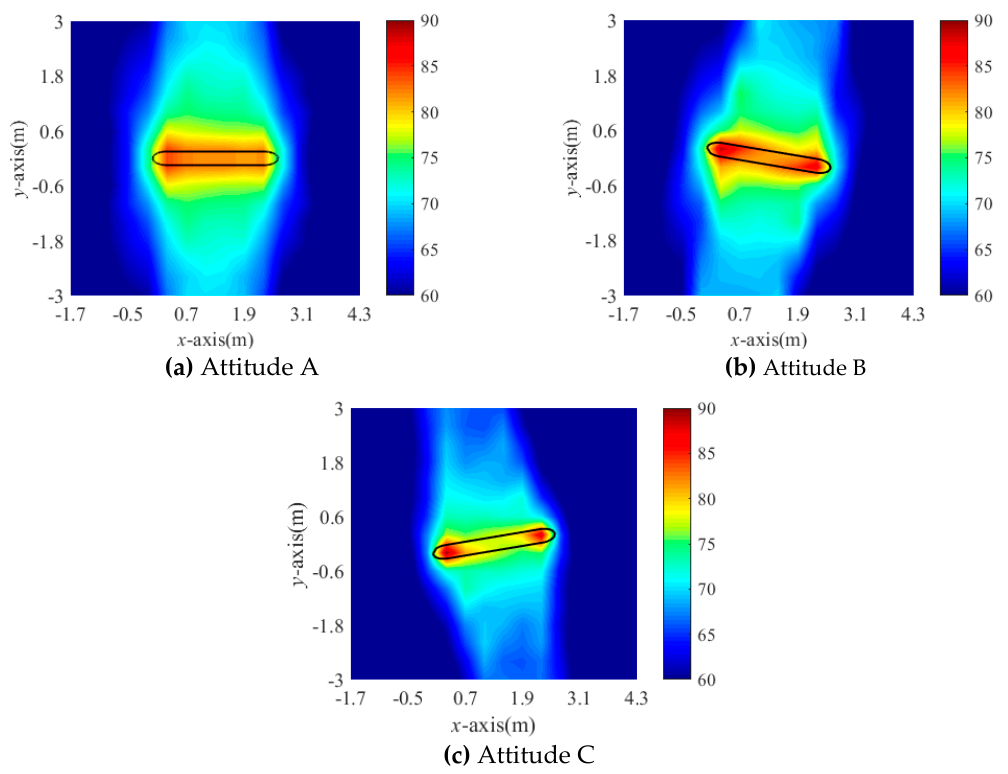
Figure 8. Radiated noise field corresponding to the flow noise of the axisymmetric body in different attitudes (center frequency is 30 kHz).